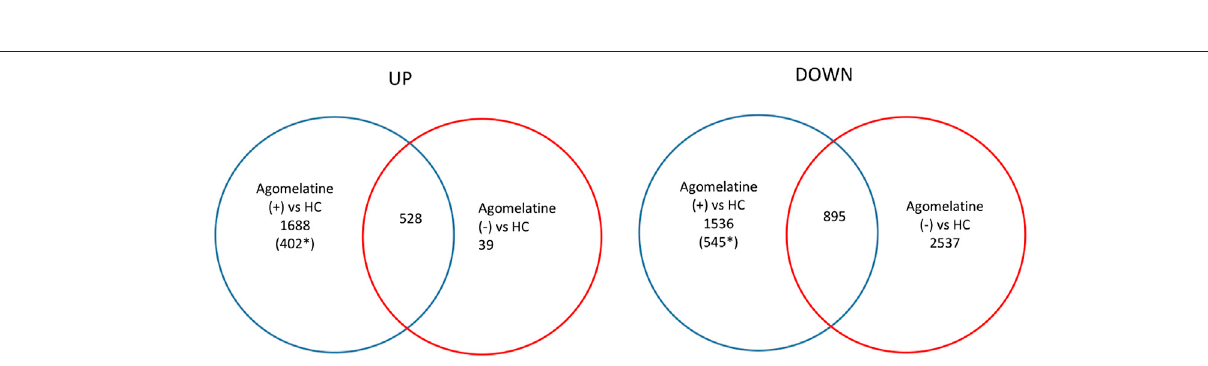
FIGURE 4 | Venn diagrams representing unique and shared differential gene expression pro fi les of agomelatine (+) & ( − ) patients, numbers of genes upregulated (UP) and downregulated (DOWN), blue ring — number of genes uniquely up- or downregulated in agomelatine (+), and red ring — number of genes uniquely up- or downregulated in agomelatine ( − ). Overlapping parts of the diagram — the number of shared genes uniquely up- or downregulated between groups of patients. (For interpretation of the references to color in this fi gure legend, the reader is referred to the Web version of this article.) *functionally known by the DAVID/KEGG database.